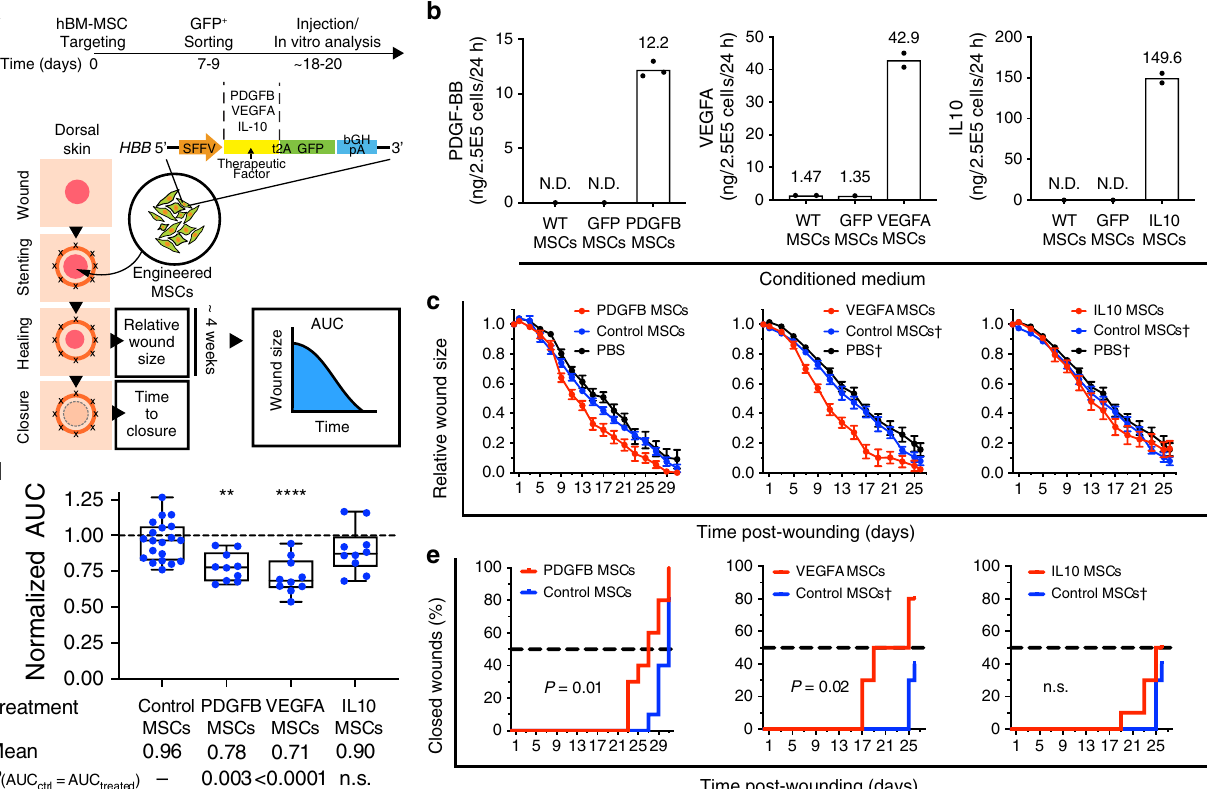
Fig. 4 Engineered therapeutic factor-secreting hBM-MSCs improved kinetics of wound healing in acute diabetic wounds. a Excisional stented wounds created on the dorsal skin of hyperglycemic (>500mg/dl blood glucose) db / db mice were treated with 2.5 × 10 5 engineered therapeutic factor-secreting hBM-MSCs and imaged with digital photography every other day until complete closure. Relative wound size were determined by measuring the wound area relative to constant silicone ring area, and normalized to original wound size. Areas under the curve (AUC) were calculated for each individual wound. Time to complete closure was determined in 2-day intervals and unclosed wounds were excluded at the end of observation periods. b Bars represent average ( n = 2 technical cell-plating replicates for all groups except PDGFB MSCs ( n = 3 technical cell-plating replicates)) total level of therapeutic proteins secreted by 2.5 × 10 5 engineered hMSCs, wild-type, and GFP-integrated controls over 24 h, as quanti fi ed by ELISA assay. c Dots and lines show changes in average relative wound size over time of engineered hBM-MSC treatments against PBS vehicle-treated and baseline MSC controls (biological replicate: n = 10 wounds per treatment group). Error bars represent standard error of mean. Daggers represent same control datasets. d Box and whiskers plots show AUC of individual wounds ( n = 10 per treatment group), which were normalized against mean AUC of PBS controls ( n = 10 PBS control wounds) within the same experimental runs. Minima and maxima are bounded by whiskers. Box lower bounds, centers, and upper bounds represent the 25th, 50th, and 75th percentiles, respectively. Mean AUCs of all treatment groups were different according to ordinary one-way ANOVA test ( p < 0.0001). Mean AUCs of engineered hBM-MSCs treated wounds were compared to that of control hBM-MSCs-treated wounds using Dunnett ’ s test. Reported p -values were corrected for multiple comparison. Asterisks indicate level of signi fi cance (** p < 0.01; **** p < 0.0001). e Kaplan – Meier ’ s plots represent time to complete wound closure of engineered hBM-MSCs treated wounds, as compared to control hBM-MSC treatment. Chi-square p -values represent signi fi cant difference in time to closure between two groups according to Log-rank test. Daggers represent same control datasets. Source data are available in the Source data fi